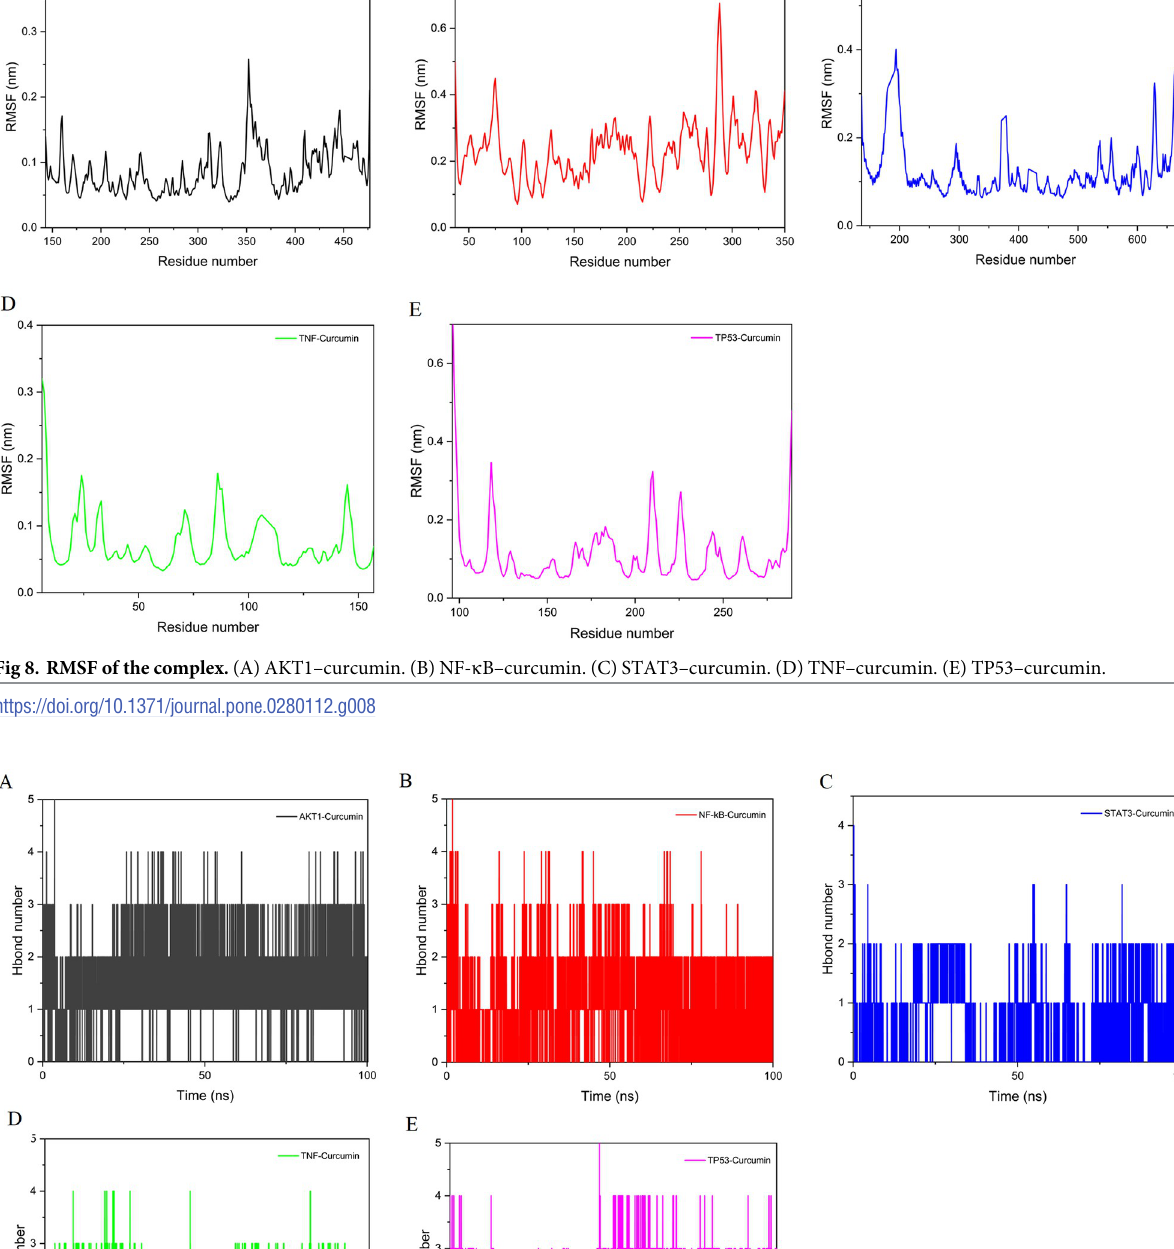
PLOS ONE | https://doi.org/10.1371/journal.pone.0280112 January 4, 2023 13 /